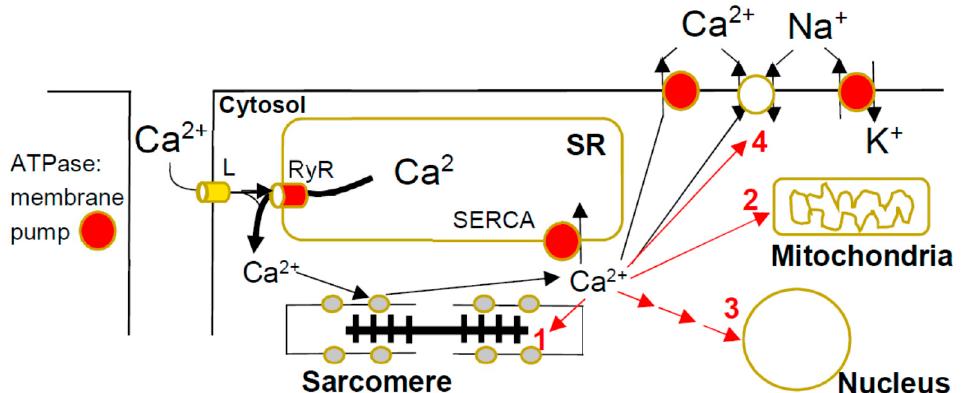
Figure 2. Calcium metabolism in cardiac myocyte and HCM-induced disturbances. The calcium ions enter during the cardiac action potential through L-type (L) Ca 2+ -channels in the T-tubule membrane and release larger amounts of Ca 2+ from the sarcoplasmic reticulum (SR). This occurs through the binding of Ca 2+ to the ryanodine receptor with opening of the integral Ca 2+ channel. The resulting increase in [Ca 2+ ] in the cytosol ([Ca 2+ ] c ) leads to Ca 2+ -binding to troponin on the thin filaments with contractile activation. The [Ca 2+ ] c is then lowered back to resting values by active pumping into the SR by the SR calcium pump (SERCA), as well as active pumping to the extracellular fluid and exchange with Na + driven by the Na + -gradient built up by the Na/K ATPase. In the presence of HCM mutations, [Ca 2+ ] c may be increased by intracellular Ca 2+ buffering due to increased binding to troponin and reduced pumping into the SR, as well as out of the cell, due to inhibition of active pumping by energy depletion. The increased [Ca 2+ ] c can exert negative effects in HCM by (1) stimulation of phosphorylation of sarcomere proteins, (2) direct effects on mitochondrial function [79], (3) activation of Ca 2+ -dependent signaling (see text below) and (4) arrythmogenicity.